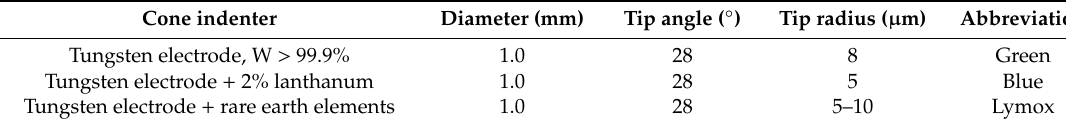
Table 2. Investigated tungsten welding electrodes as cone indenters.